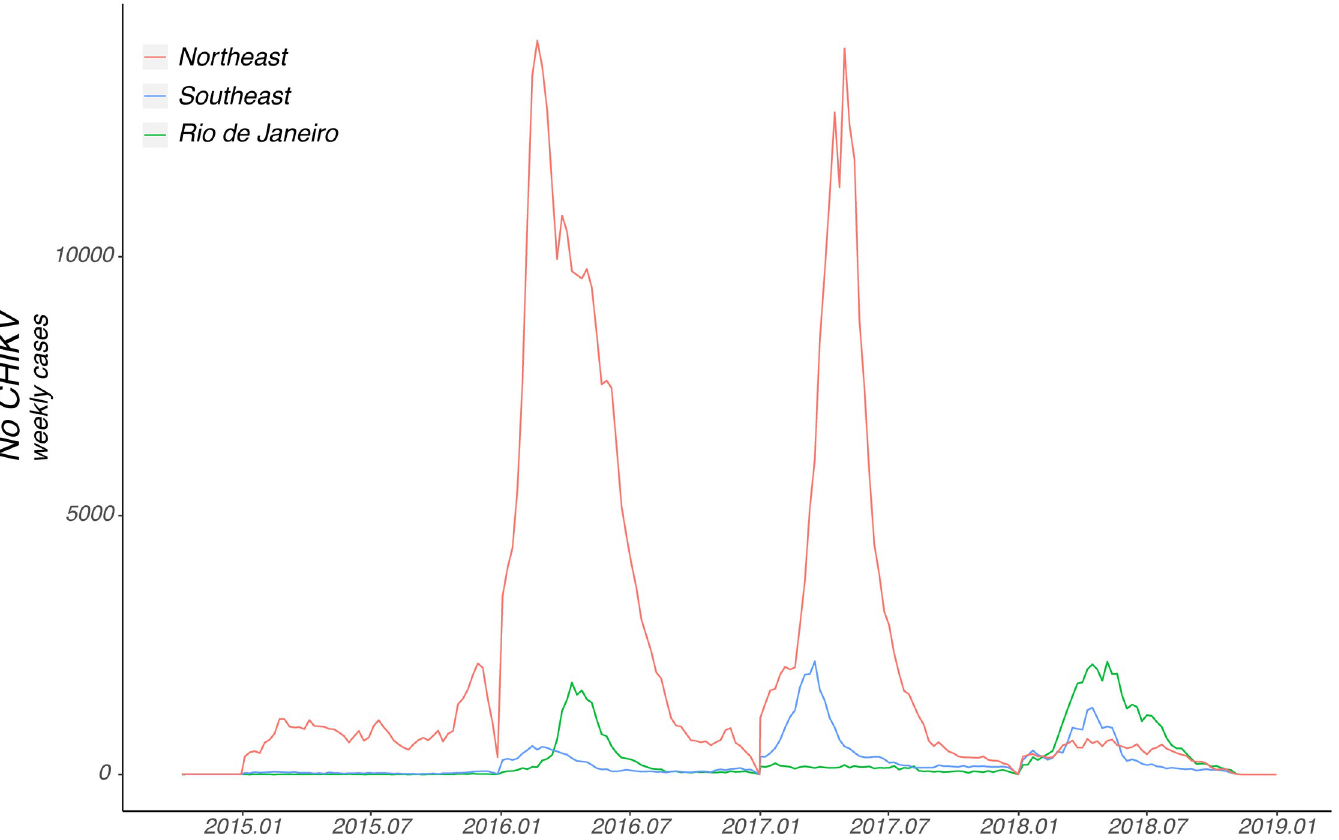
Fig 3. Weekly notified Chikungunya fever cases in the north-eastern and south-eastern regions of Brazil, 2015–2018. Number of chikungunya fever cases by epidemiological week registered in the north-eastern and south-eastern regions of Brazil between 2015 and 2018. Epidemic curves are coloured according to geographical region (see legend). Number of cases from the state of Rio de Janeiro alone is represented by the green curve and it is not computed in the curve from southeast. Chart was generated by R software.